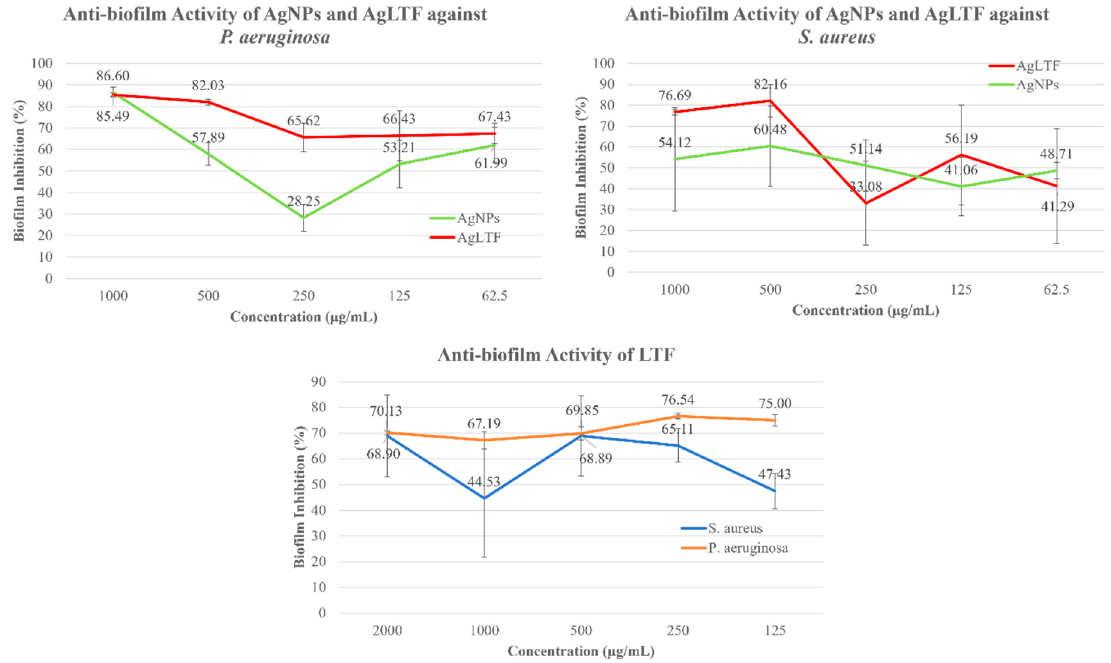
Figure 9. Anti-biofilm activity of AgNPs, LTF, and AgLTF against S. aureus and P. aeruginosa using the crystal violet assay, n = 3.